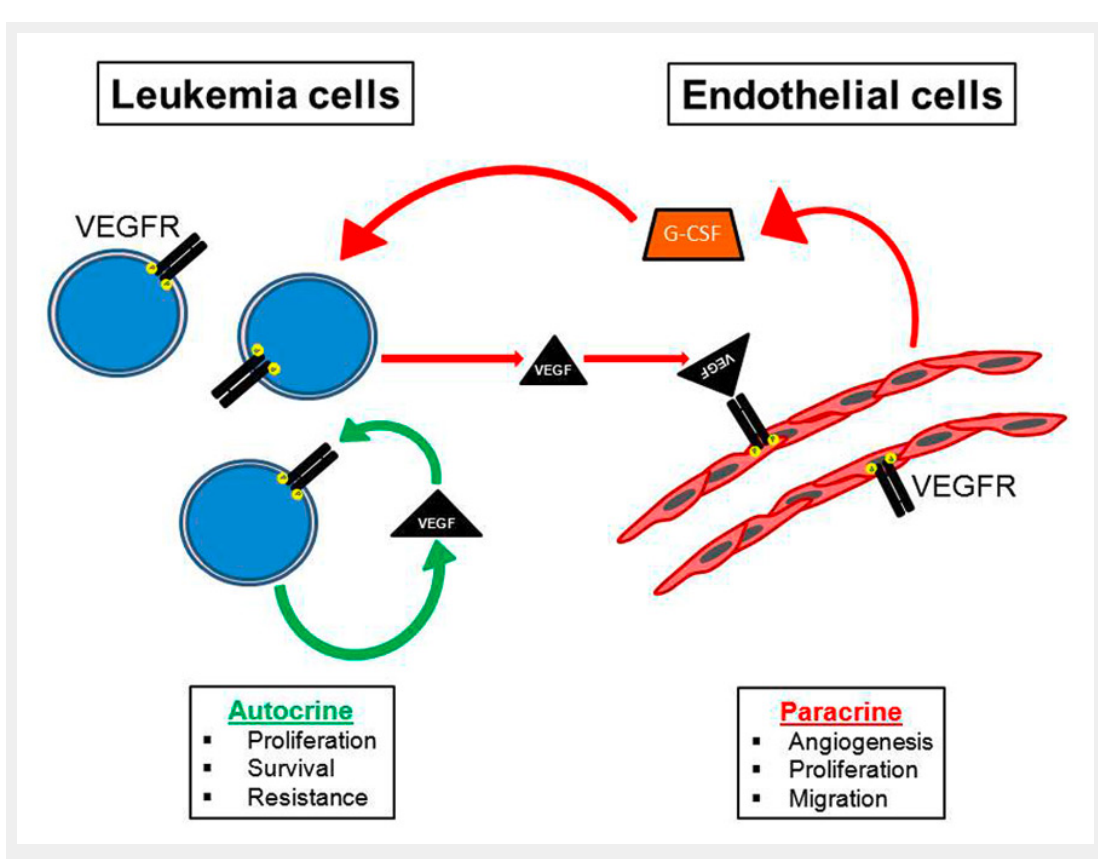
Figure 1 Cross-talk between leukaemic and endothelial cells. Autocrine and paracrine signalling via VEGF promotes the pathogenesis of leukaemia. Paracrine VEGF signalling influences angiogenesis and the bone marrow microenvironment. G-CSF = granulocyte-colony stimulating factor; VEGF = vascular endothelial growth factor; VEGFR = vascular endothelial growth factor